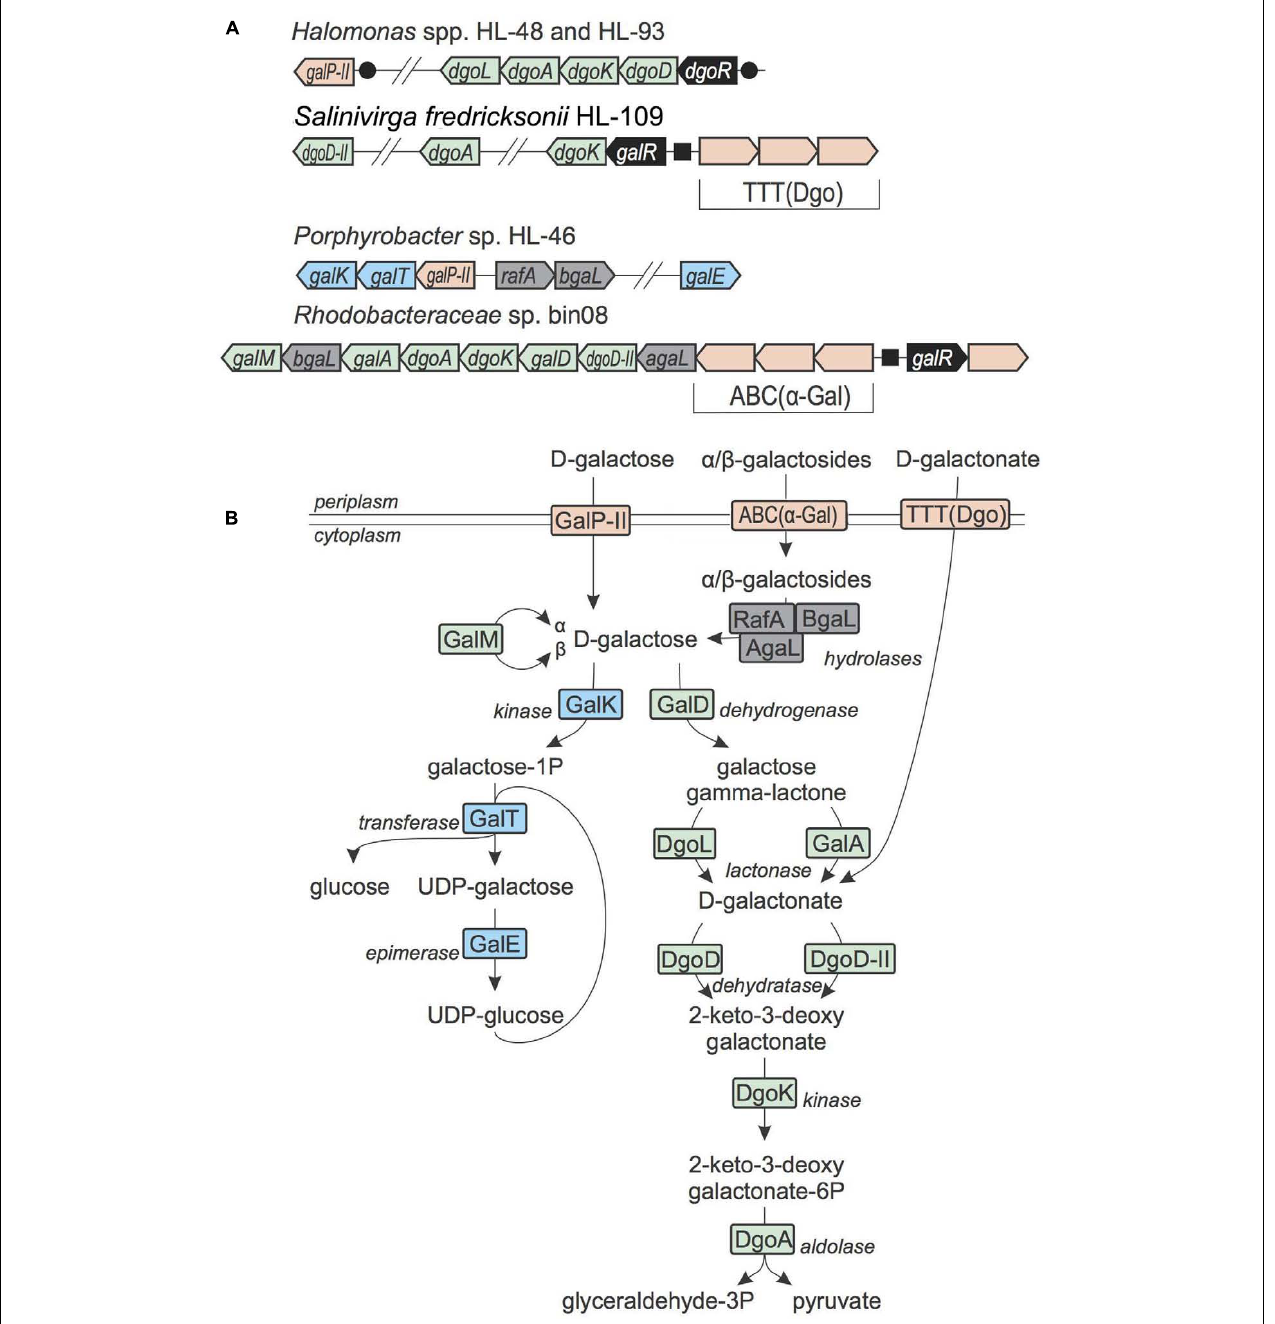
FIGURE 5 | D -Galactose, galactoides, and D -galactonate utilization in UCC bacteria. (A) Loci containing D -galactose, galactosides, and D -galactonate utilization genes. Genes are colored by their general functional roles: transcription factors (black), transporters (pink), the Leloir pathway enzymes (blue), the DeLey-Doudoroff pathway enzymes (green), glycosyl hydrolases (gray). Candidate DNA binding sites are shown as circles (for DgoR) and squares (for GalR). (B) Scheme of D -galactose, galactosides, and D -galactonate utilization pathways. Enzymes are colored by matching colors as in (A) .